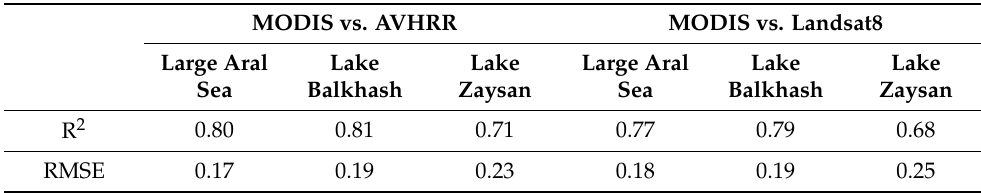
Figure 2. Time series of the water–ice fraction in the Large Aral Sea ( a ), Lake Balkhash ( b ), and Lake Zaysan ( c ) derived from the MODIS LST daily-combined image and AVHRR daily SST product from 2002 to 2020. Table 1. The R 2 and RMSE for the comparison between the MODIS daily LST combined image, AVHRR and